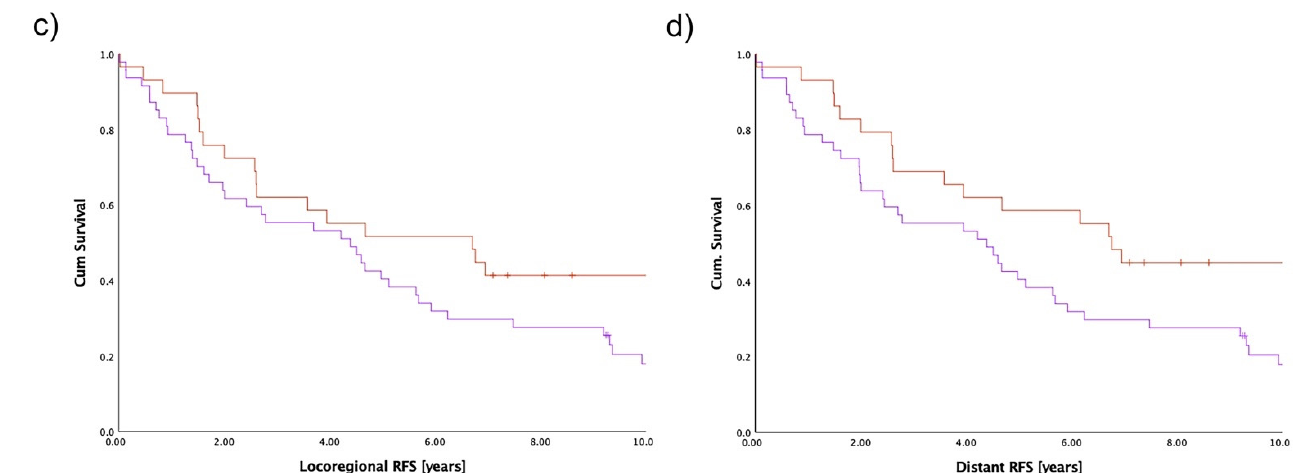
Figure 4. Survival of OSCC patients based on TIGIT expression on CD3+ intratumoral cells assessed by immunostaining of TMA slides. The patient cohort was separated by a median cutoff. ( a ) OAS in the complete cohort ( n = 76, p = 0.025); ( b ) local RFS ( n = 76, p = 0.129); ( c ) locoregional RFS ( n = 76, p = 0.080); ( d ) distant RFS ( n = 76, p = 0.026).